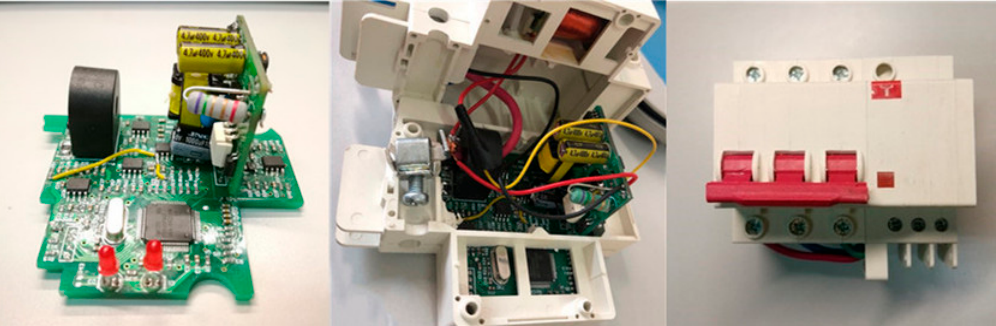
Figure 12. Prototype of an AFDD.